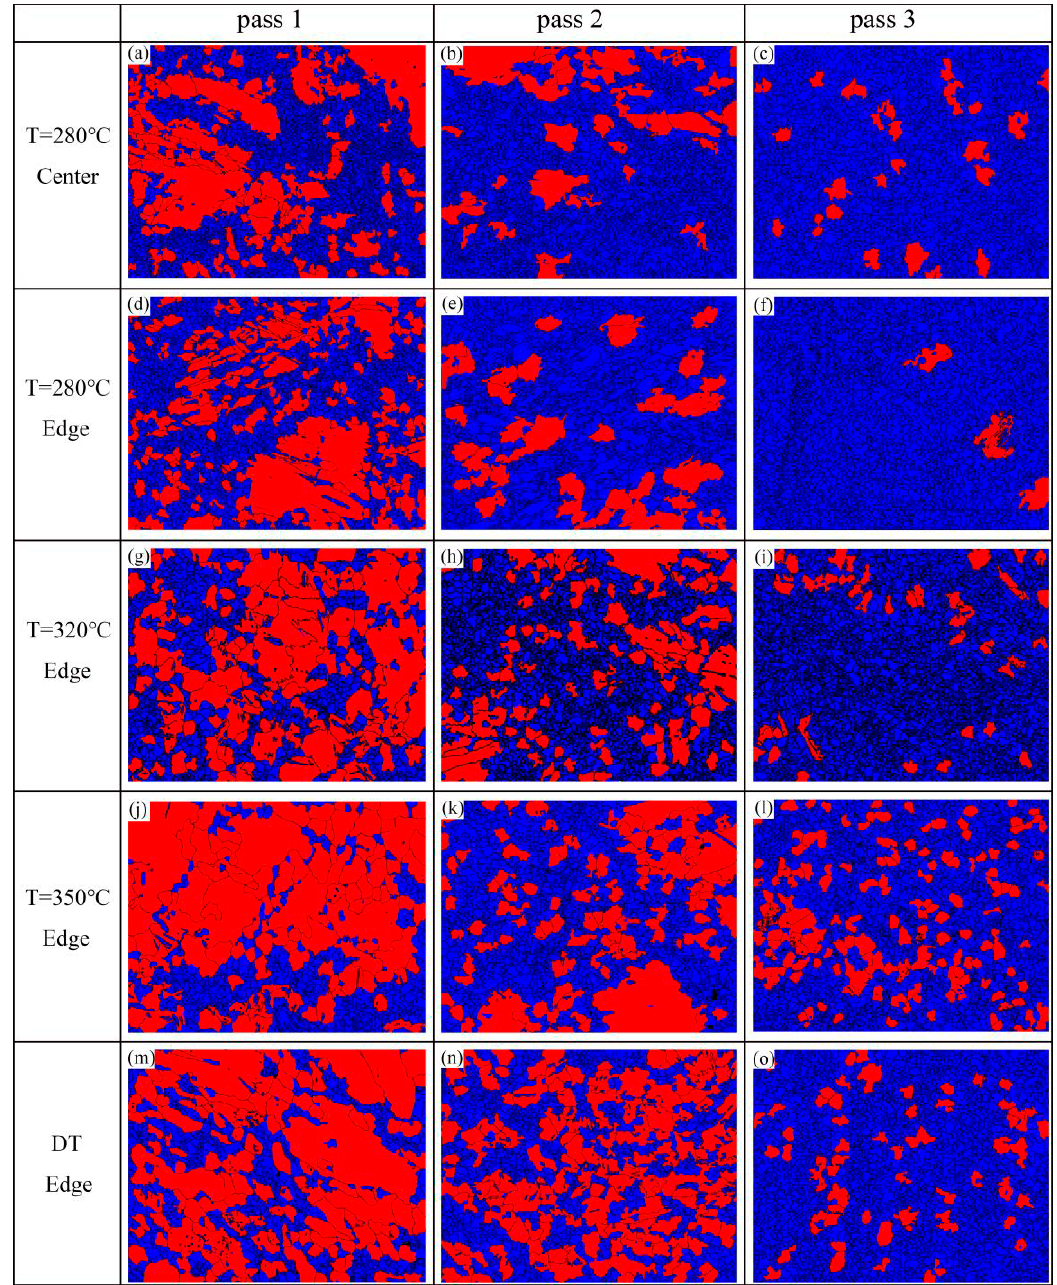
Figure 12. The EBSD maps distinguished recrystallization region (blue area) and deformed region (red area) of different samples: ( a ) Center pass 1 at 280°C; ( b ) Center pass 2 at 280°C; ( c ) Center pass 3 at 280°C; ( d ) Edge pass 1 at 280°C; ( e ) Edge pass 2 at 280°C; ( f ) Edge pass 3 at 280°C; ( g ) Edge pass 1 at 320°C; ( h ) Edge pass 2 at 320°C; ( i ) Edge pass 3 at 320°C; ( j ) Edge pass 1 at 350°C; ( k ) Edge pass 2 at 350°C; ( l ) Edge pass 3 at 350°C; ( m ) Edge pass 1 at DT; ( n ) Edge pass 2 at DT; ( o ) Edge pass 3 at DT.